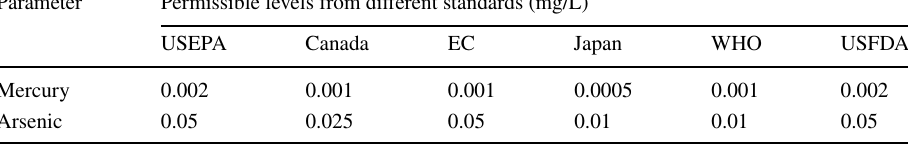
Table 3 Permissible limits of drinking water quality (WHO 1993)